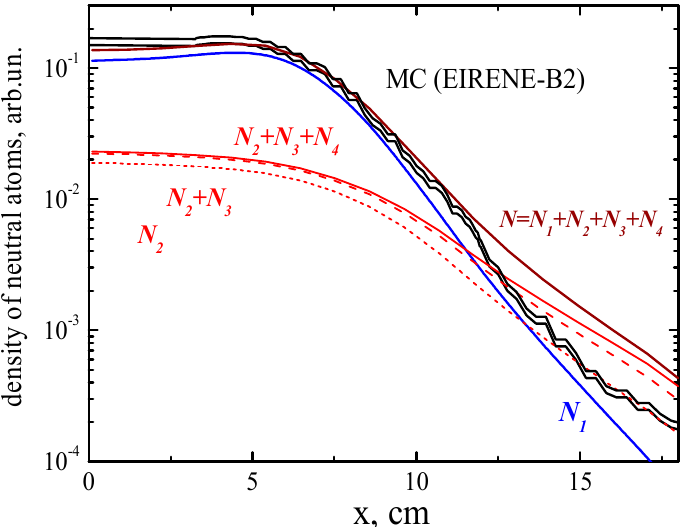
Figure 4. Comparison of space profiles of molecules and molecular ions of deuterium for the outer part of horizontal chord. Solid line—ballistic model, histogram (stepped line)—EIRENE code simulations.